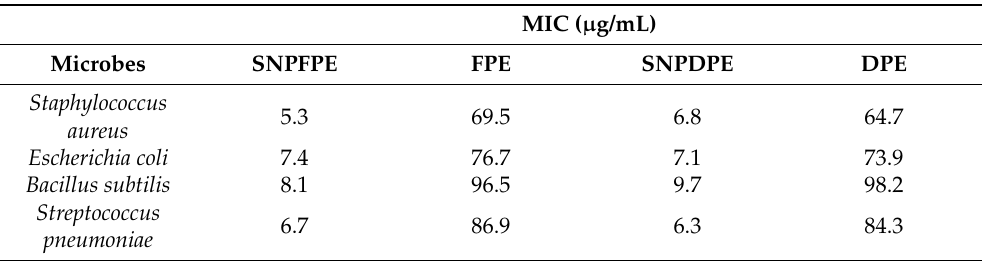
Table 2. Minimum inhibitory concentration of silver NPs and parent plant extracts on the microbici- dal viability.